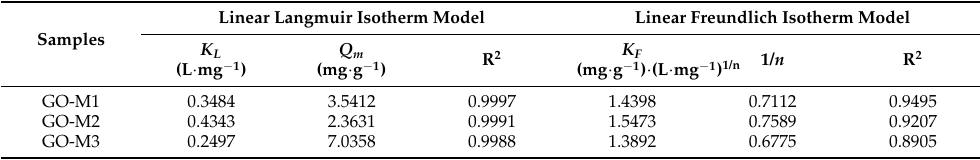
Table 6. Calculation parameters of isotherms for the adsorption of Cr(VI) on GOs.